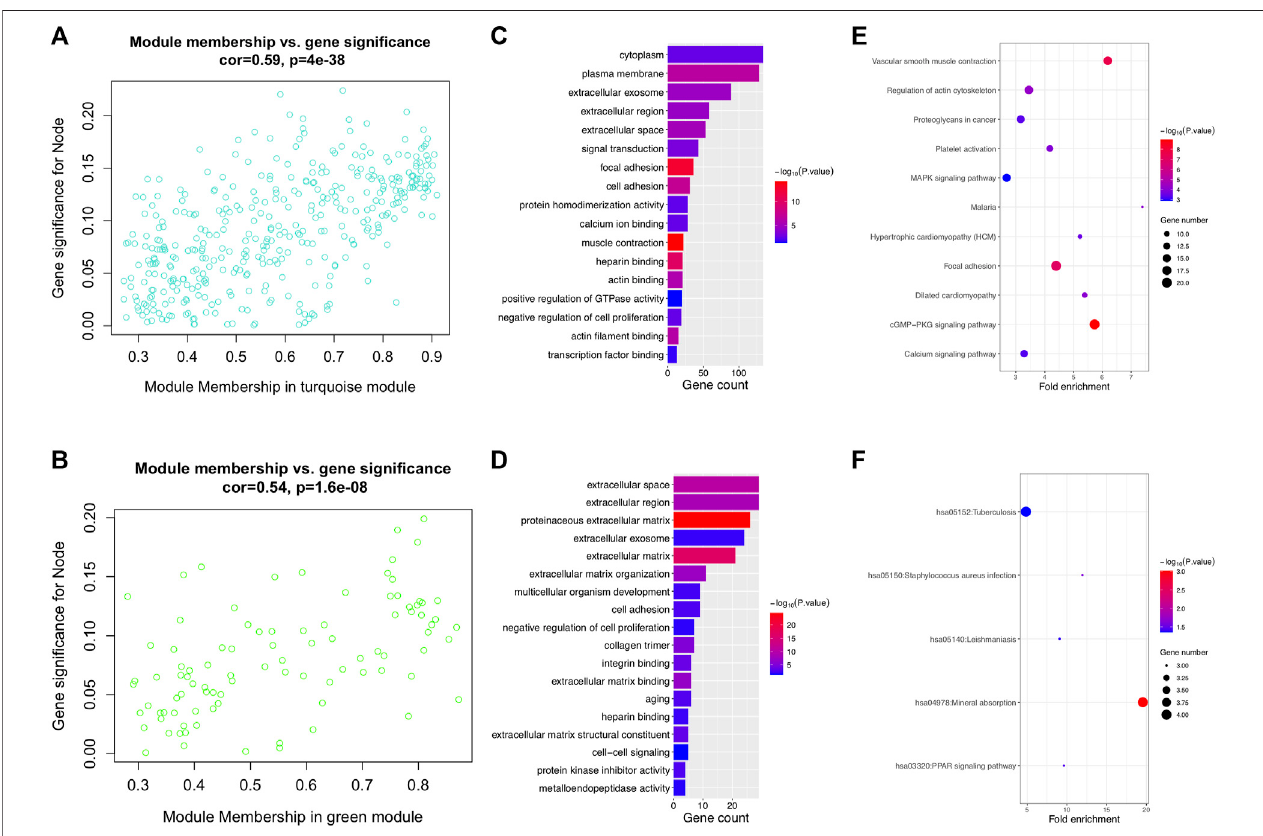
FIGURE 2 | Lymph node metastasis – related modules and function analysis. (A, B) Scatterplot of module eigengenes in turquoise and green modules. (C, D) GO enrichment analysis of turquoise and green modules. (E, F) KEGG enrichment analysis of turquoise and green modules. GO: gene ontology and KEGG: Kyoto Encyclopedia of Genes and Genomes.